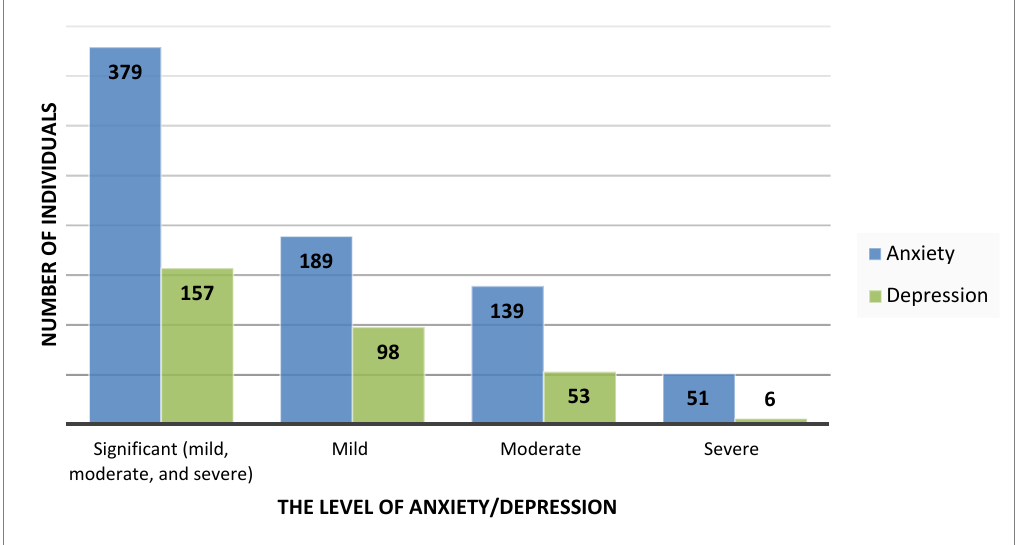
Figure 1. The level of anxiety and depressive symptoms in the entire study group ( n = 604).